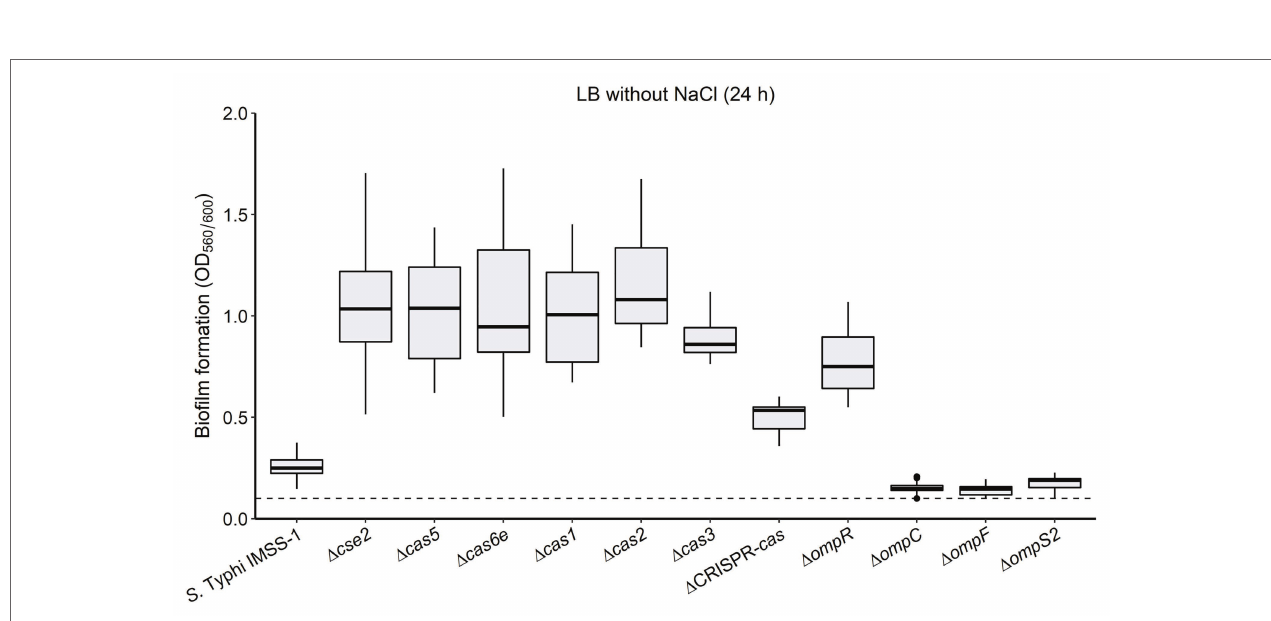
FIGURE 6 | The absence of the CRISPR-Cas system increases biofilm formation in Salmonella Typhi. The Salmonella Typhi IMSS-1 wild type, and Δ cse2 , Δ cas5 , Δ cas6e , Δ cas1 , Δ cas2 , Δ cas3 , Δ CRISPR- cas , Δ ompR , Δ ompC , Δ ompF , and Δ ompS2 mutant strains were grown in LB broth without NaCl and incubated at 30 ° C for 24 h to evaluate biofilm formation by crystal violet staining in microtitre dishes. The dotted line indicates a 0.1 background value and a bacterial strain produces biofilm when the values obtained are above 0.1. The box plot diagram represents the data obtained from three independent